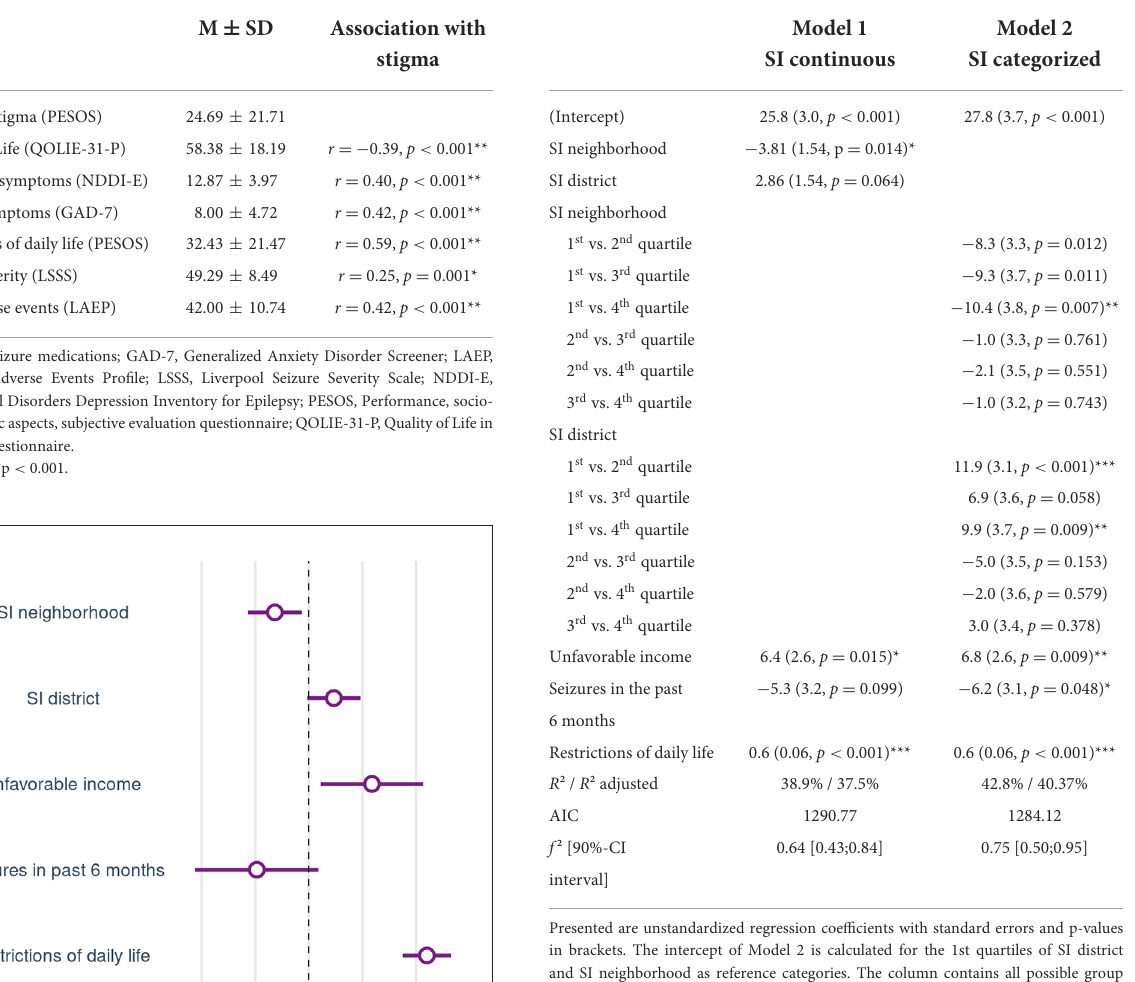
TABLE 2 Answers on self-report questionnaires.